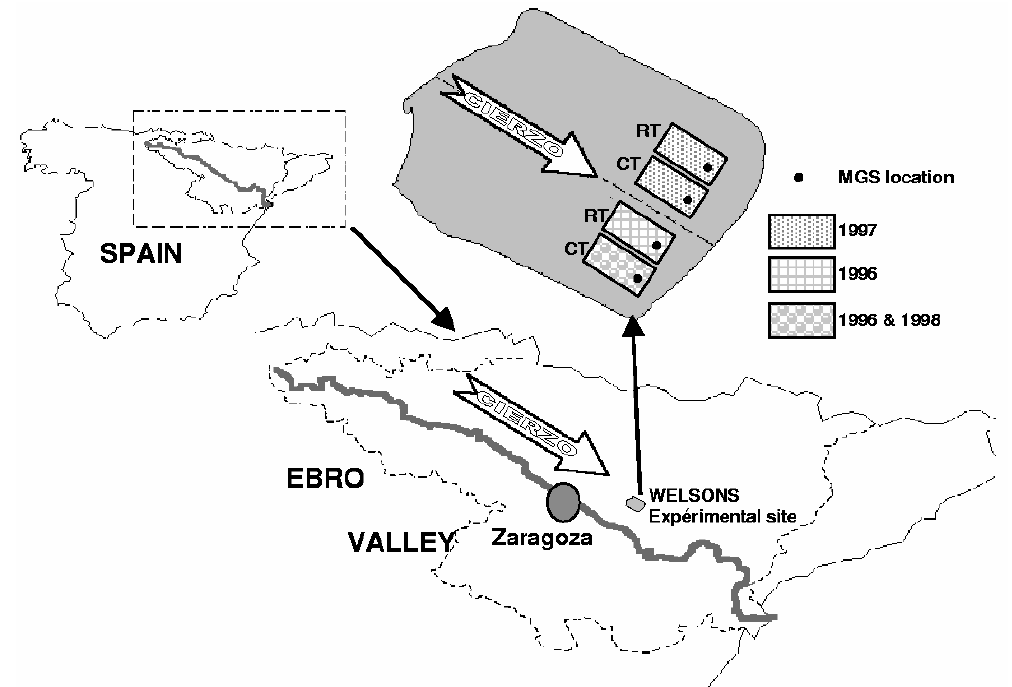
Figure 1: General fetch of the WELSONS experimental site. One can notice the location of the conventional tillage (CT) and reduced tillage (RT) plots, changing according to years and the main wind direction following the Ebro valley (after Yahaya et al., 2003). Table 2. Some values of C ε according to the values of the normalised kinetic